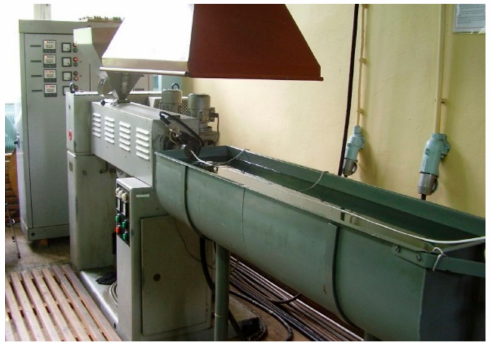
Figure 2. Station for testing the process of microcellular extrusion.